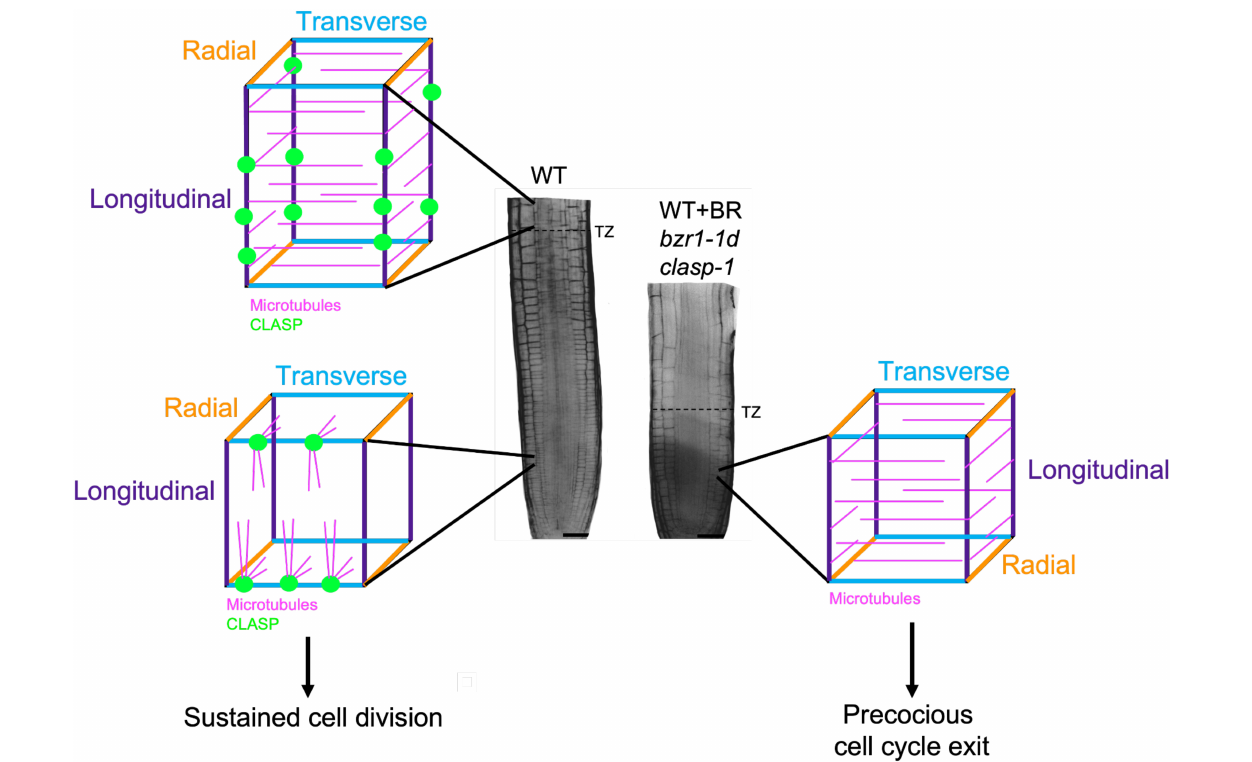
FIGURE 2 | CLASP localization and microtubule organization in interphase cells in the root meristem. In the division zone of wild-type (WT) RAMs (lower left), CLASP (green) distributes to the sharp transverse edges (blue) formed from recent cell divisions. This promotes the formation of TFBs, allowing microtubules (pink) to grow around these edges. In the elongation zone of WT roots (upper left), CLASP localizes to the longitudinal edges (purple) and a primarily transverse array of microtubules forms respective to the axis of growth. In the division zone of plants with CLASP downregulated ( WT + BR, bzr1-1d ) or absent ( clasp-1 ) (right), the lack of CLASP causes microtubules to adopt a primarily transverse array, which is associated with precocious cell cycle exit. This leads to a smaller meristem as marked by an earlier transition zone (dotted line on root) when compared to the WT.